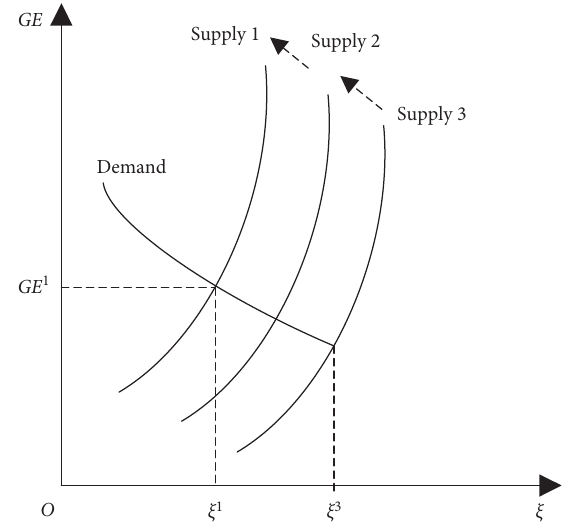
Figure 3: Coordinated optimization of the complex system for the